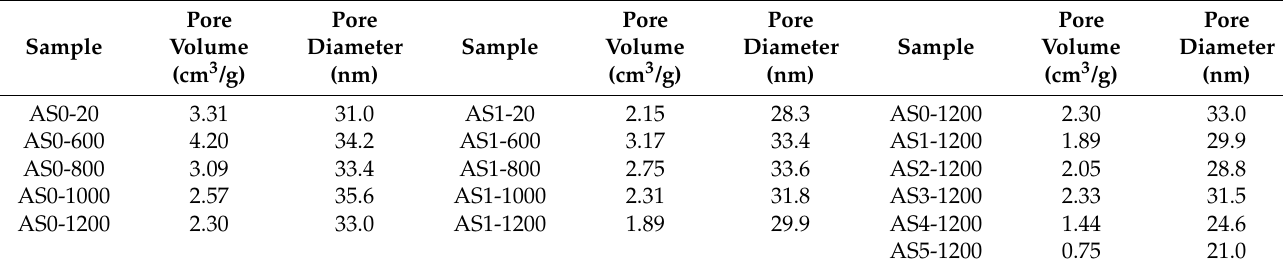
Table 2. Average pore diameter and pore volume of AS